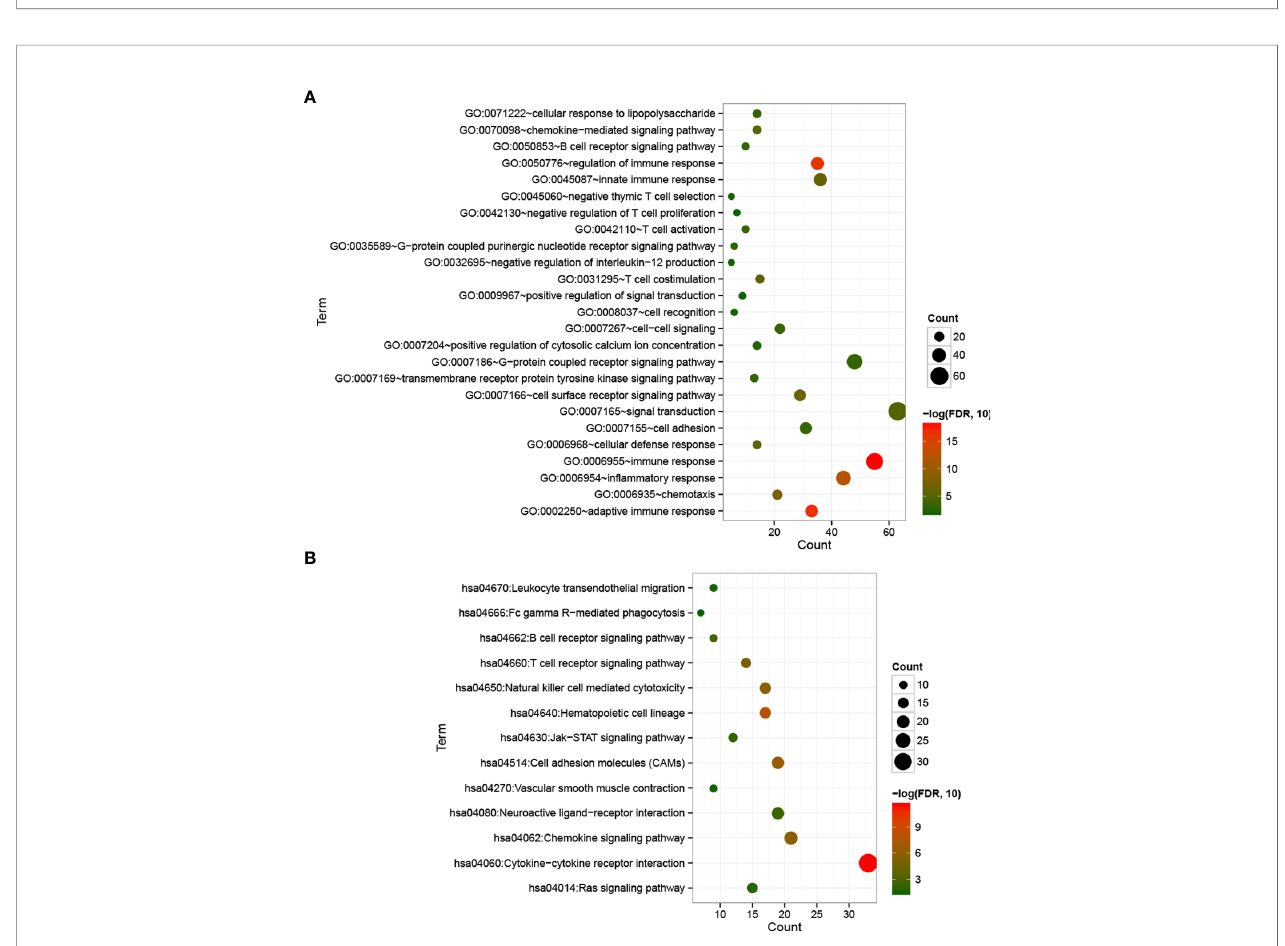
FIGURE 5 | Bubble maps of biological processes (A) and KEGG signaling pathways (B) associated with signi fi cantly differentially expressed genes. The horizontal axis represents the number of differentially expressed genes, the vertical axis represents the name of the item, and the size of the dot represents the number of